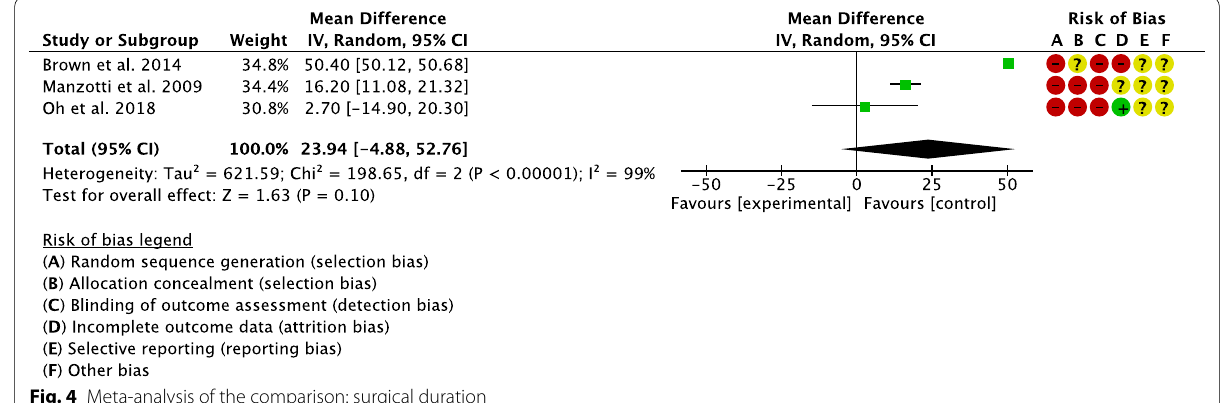
Fig. 4 Meta-analysis of the comparison: surgical duration